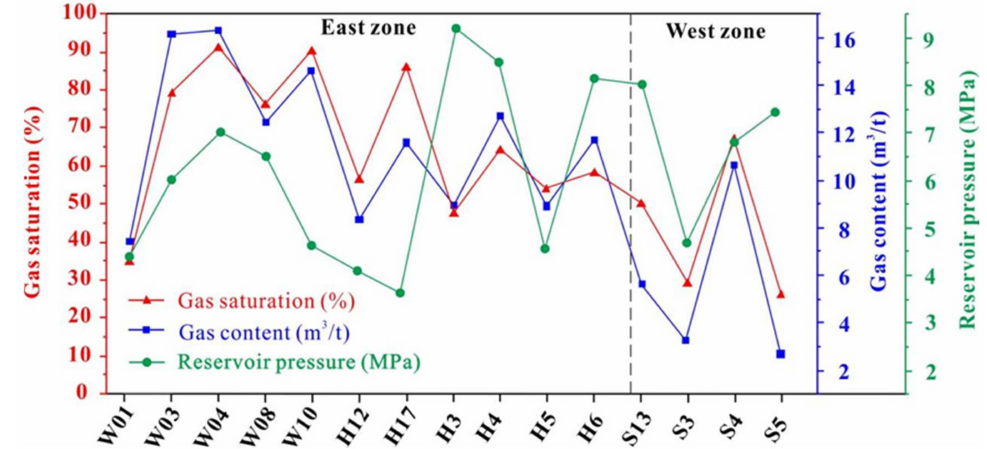
Figure 11. Relationship of gas content, gas saturation, and reservoir pressure of the No.5 coal seam in the Weibei